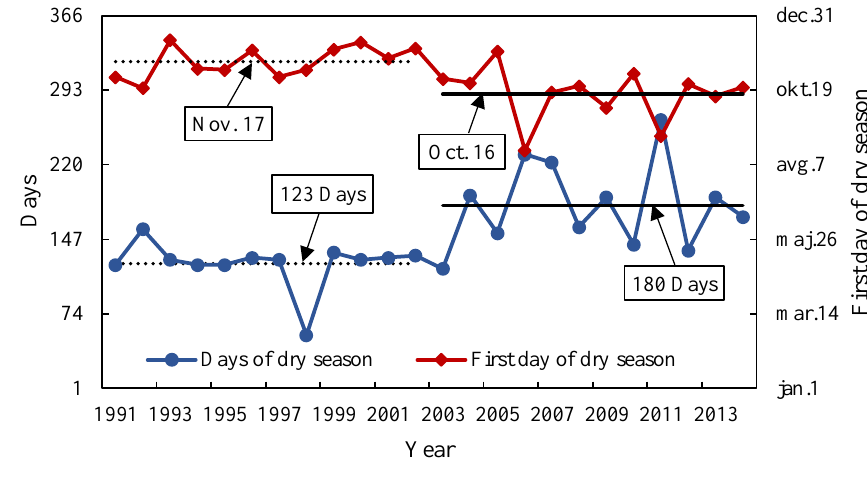
Figure 3. Duration and starting date of the dry season of Poyang Lake.